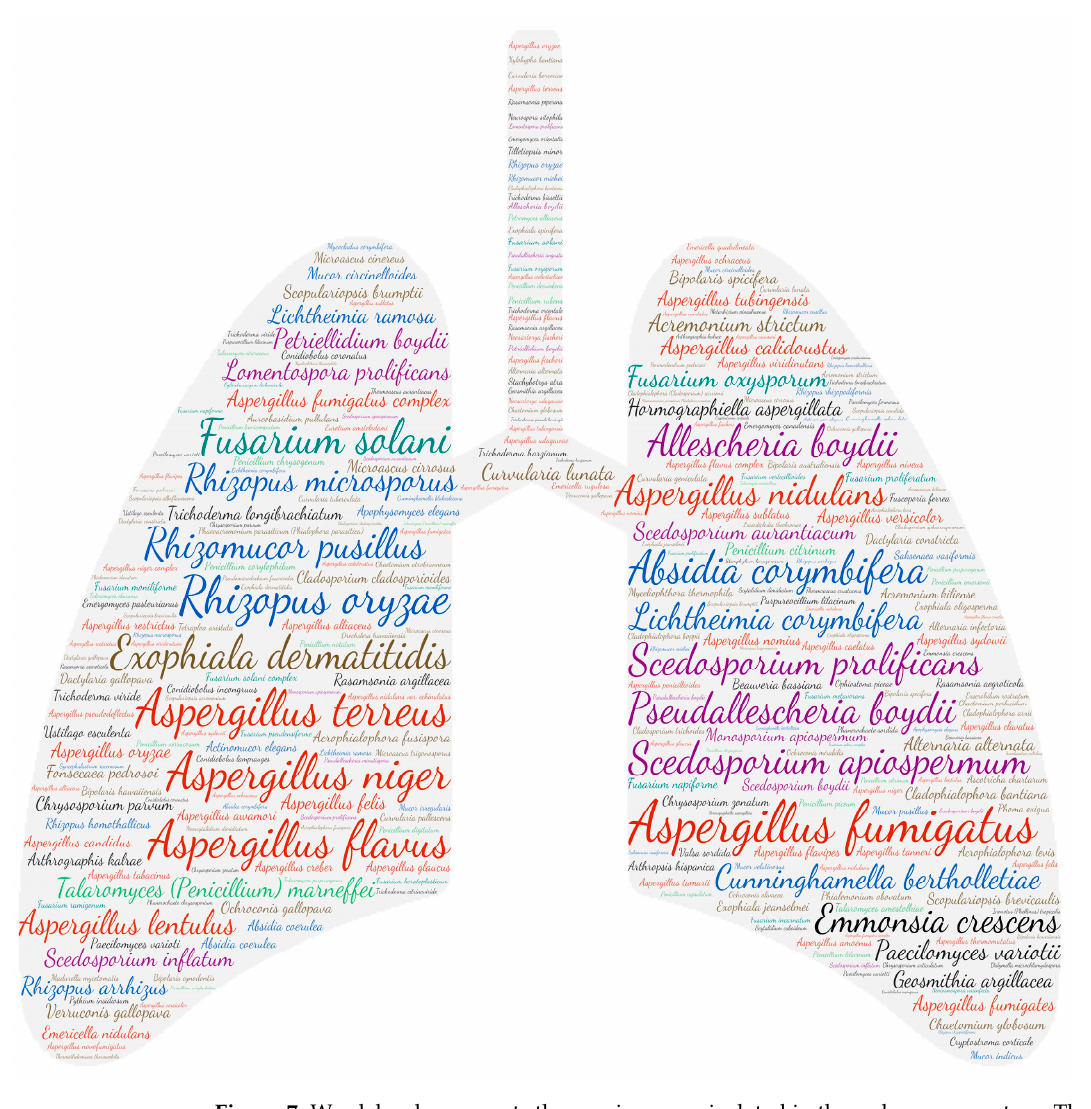
Figure 7. Wordcloud represents the species name isolated in the pulmonary system. The size of the name of each species is proportional to the number of times it occurs in the repertoire.